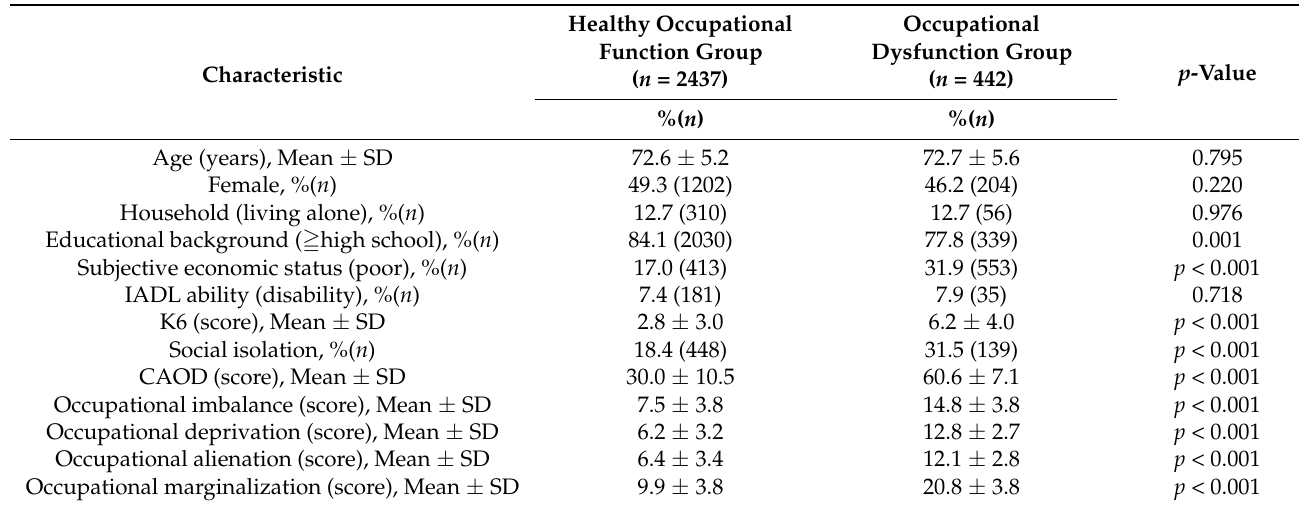
Table 1. Participants’ characteristics.